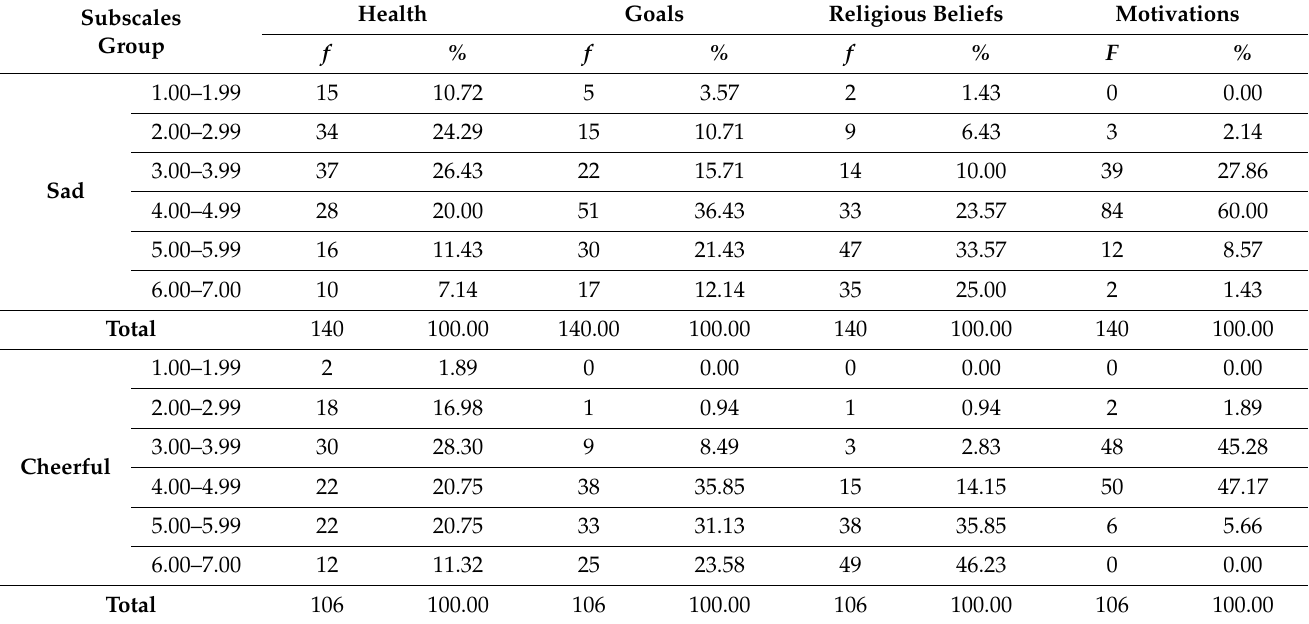
Table 3. Distribution of the results in the NCN-36 subscales due to the mood of the